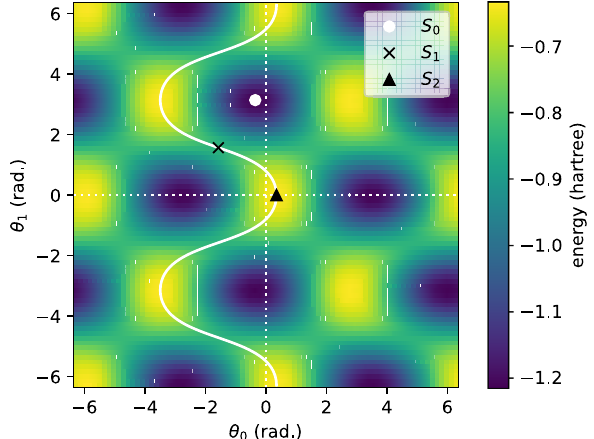
Fig. 3 Energy landscape (in Hartree) of ethylene plotted against two circuit parameters θ 0 and θ 1 (in radian). The energies of ethylene were computed at the FC structure using the CASCI/STO- 3G method, whose active space included two electrons in two orbitals. One of the minimum energy points (S 0 ), the fi rst-order saddle point (S 1 ), and the second-order saddle point (S 2 ) are shown by the white circle, black x, and black triangle, respectively. The white solid line represents the region where the wavefunction is orthogonal to S 0